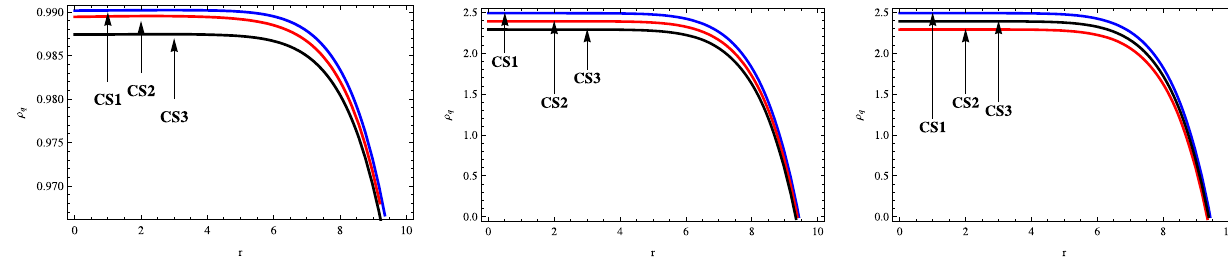
Fig. 4 Variations of ρ q ( MeV / f m 3 ) versus r ( km ) with the numerical values of A , B and C from Tables 2, 3 and 4 respectively